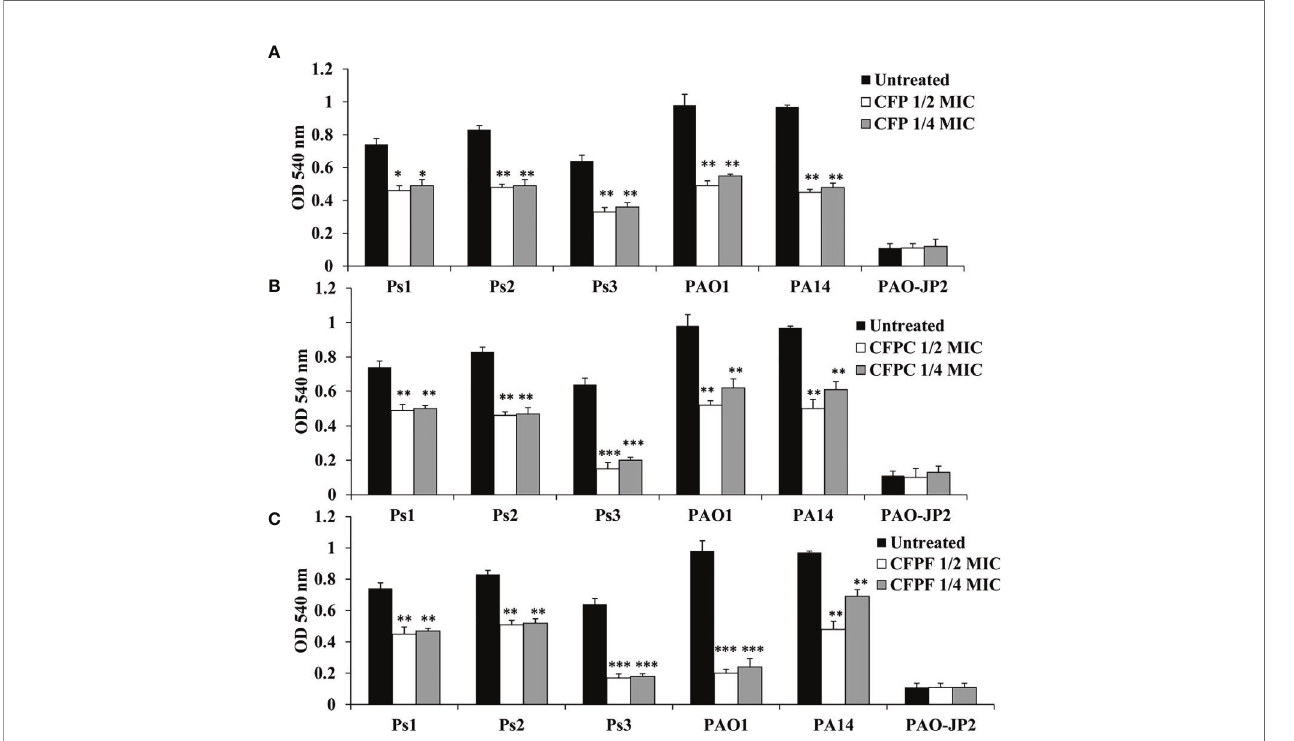
FIGURE 3 | Hemolysin activity; Effect of sub-MICs; 1/4 and 1/2 of Cefoperazone (CFP) (A) Cefoperazone-Cobalt complex (CFPC) (B) and Cefoperazone-Iron complex (CFPF) (C) on hemolysin activity measured at OD 540 nm in P. aeruginosa strains, Ps1, Ps2, Ps3, PAO1, PA14 and PAO-JP2 (negative control) compared to the untreated cultures. Error bars represent S.D. (n = 3), * p ≤ 0.05, ** p ≤ 0.01, and *** p ≤